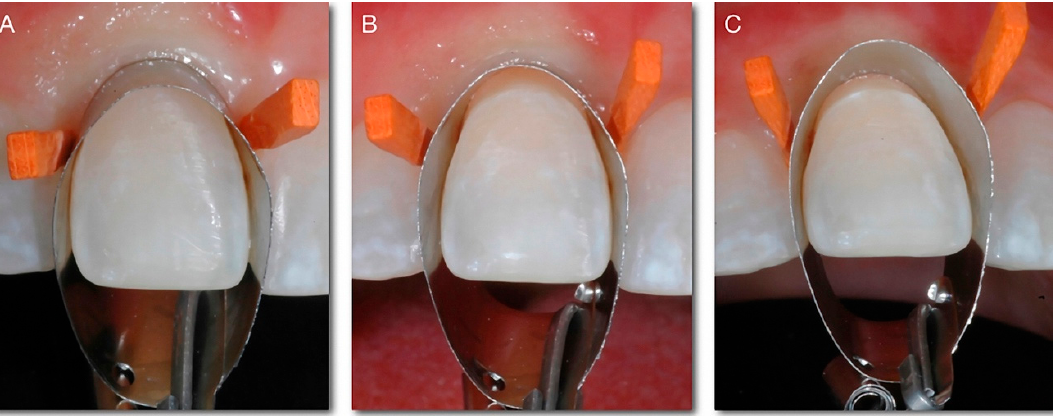
Figure 1. ( A ) The matrix is positioned around the tooth, tilted and pushed in the cervical direction, held adjacent to the tooth, and slid apically to fit the gingival sulcus. ( B ) In this way, it is possible to obtain an isolation of the operative site, and an easy application of the adhesive and composite. ( C ) It is possible to modify the emergence angle, and reconstruct a new “artificial